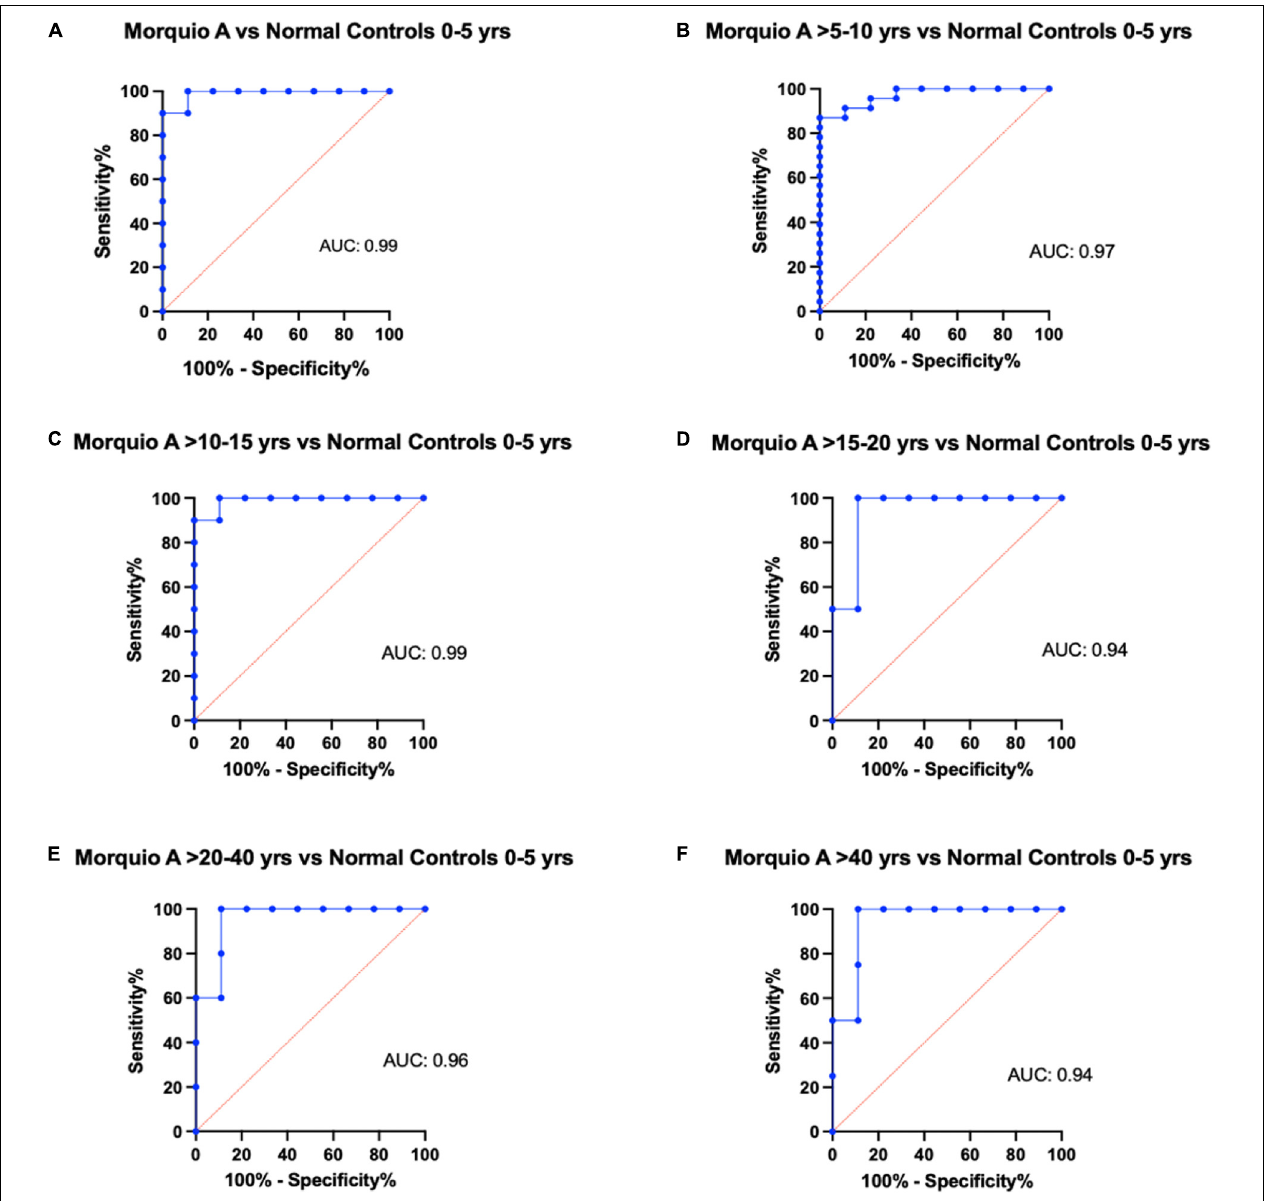
FIGURE 3 | Representative figures of receiver operating characteristic (ROC) curves for cathepsin S comparing different age groups. Comparison of the diagnostic ability of Cathepsin S in the Morquio A cohort and the normal cohort stratified by age. Comparison of normal controls 0 to 5 years of age with: (A) Morquio A patients 0 to 5 years of age, (B) Morquio A patients > 5 to 10 years of age, (C) Morquio A patients > 10 to 15 years of age, (D) Morquio A patients > 15–20 years of age, (E) Morquio A patients > 20 to 40 years of age, and (F) Morquio A patients > 40 years of age. AUC, Area under the